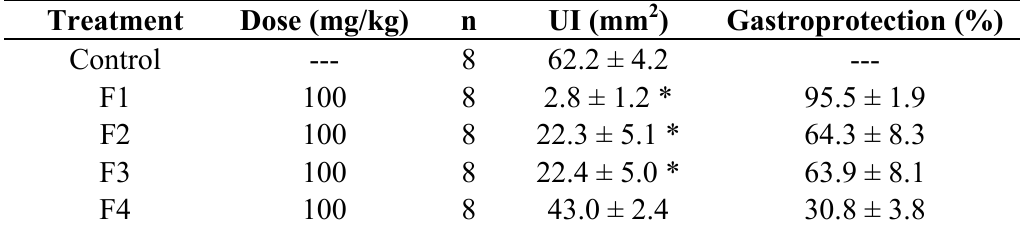
Table 2. Gastroprotective effect of the fractions of hexane extract on ethanol-induced ulceration in rats.